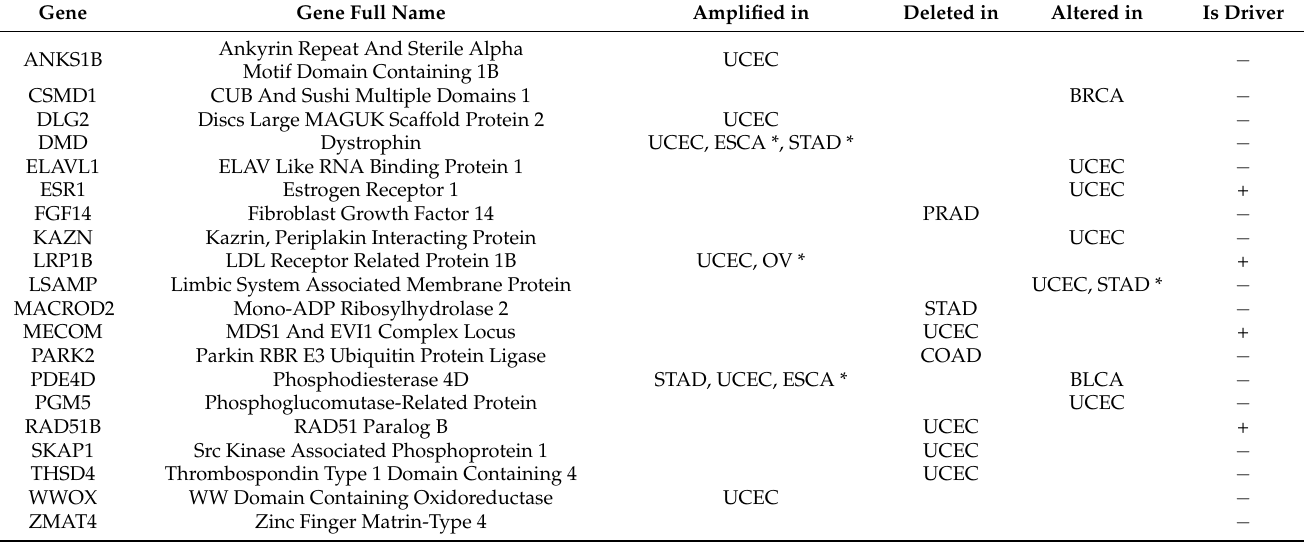
Table 2. Significant CNA